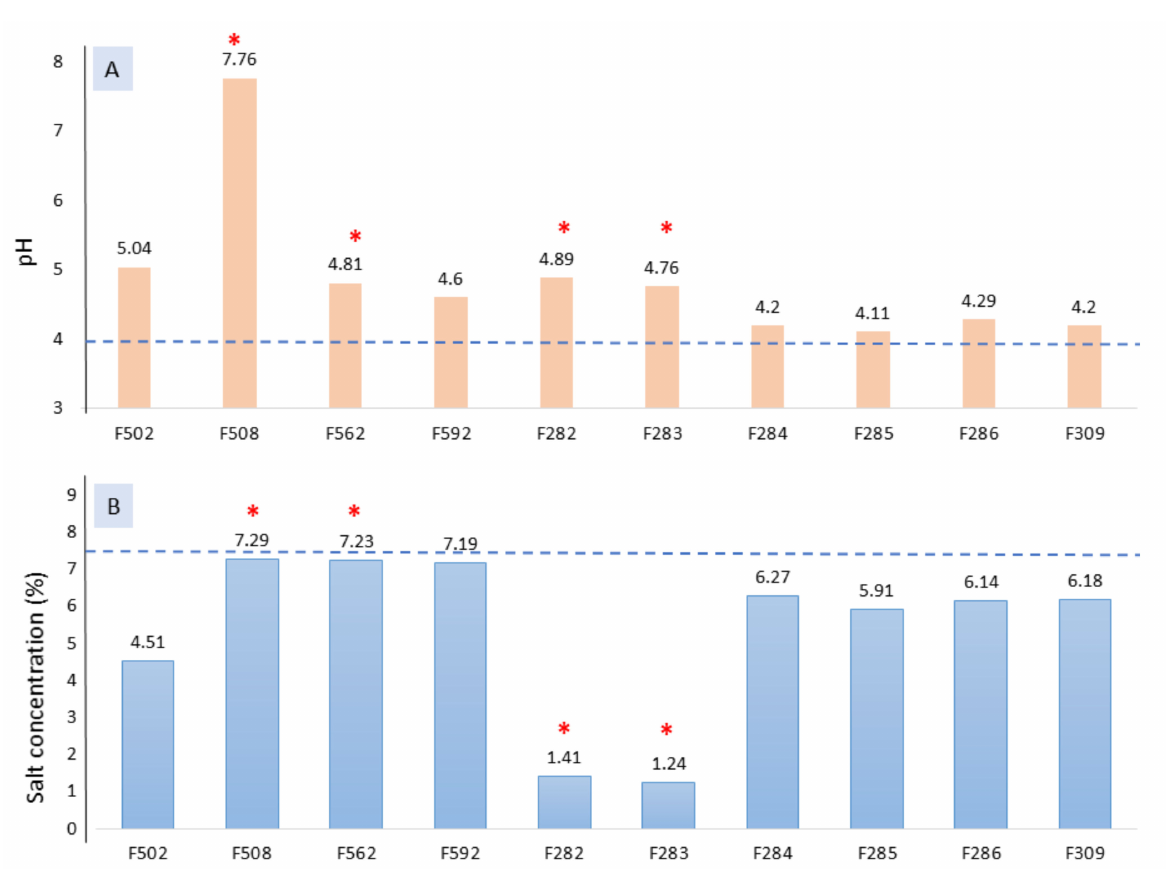
Figure 1. pH ( A ) and salt ( B ) values obtained for the different fermentation vessels at 1 month of fermentation. The horizontal line stands for habitual values under normal conditions for lye treated olive post-fermentation storage [1]. * Spoiled